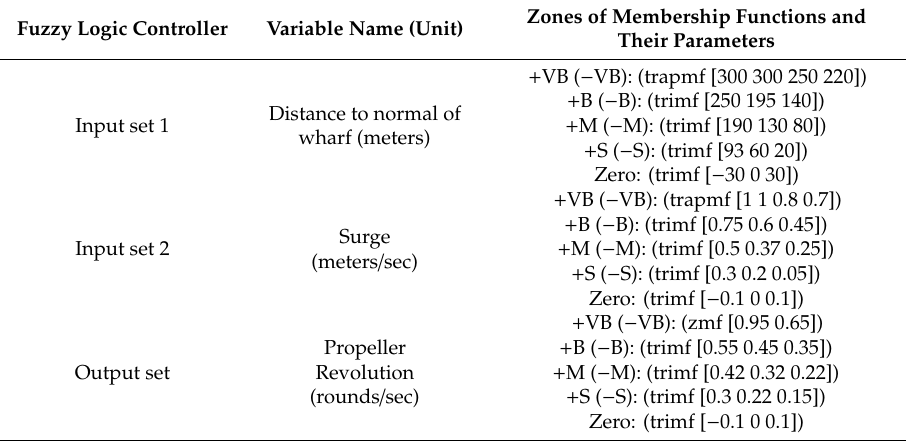
Table 4. The parameters of longitudinal movement controller.